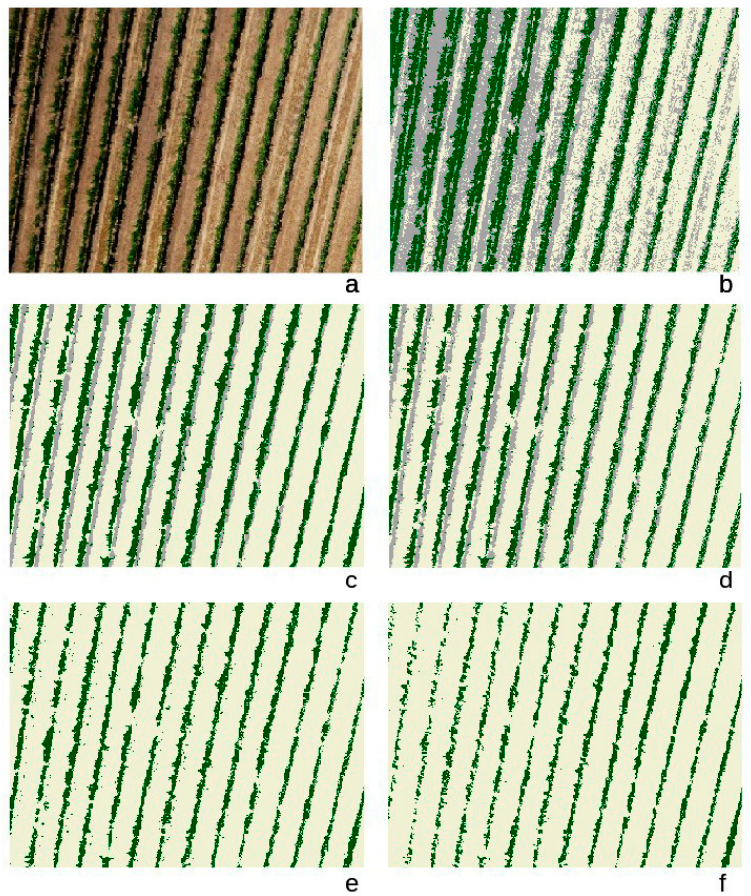
Figure 2. Classification results for the different methods using R, G, B channels and the spectral indices as input data. In green plant class, beige: soil class and dark gray: shadow class. ( a ) original image; ( b ) K-means.ex; ( c ) ANN.ex; ( d ) RForest.ex; ( e ) G% and ( f ) 2G_RBi.